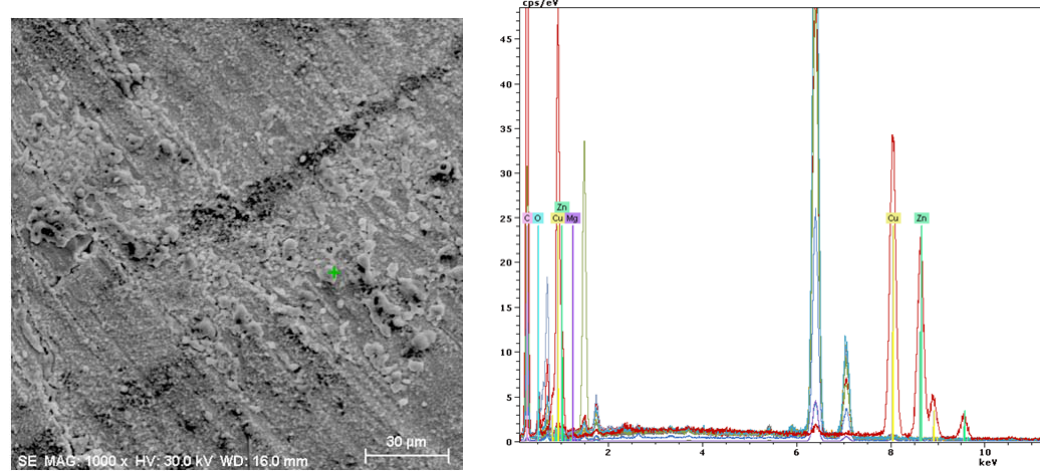
Figure 7. SEM and EDX analysis bronze Cu95Al5 sample